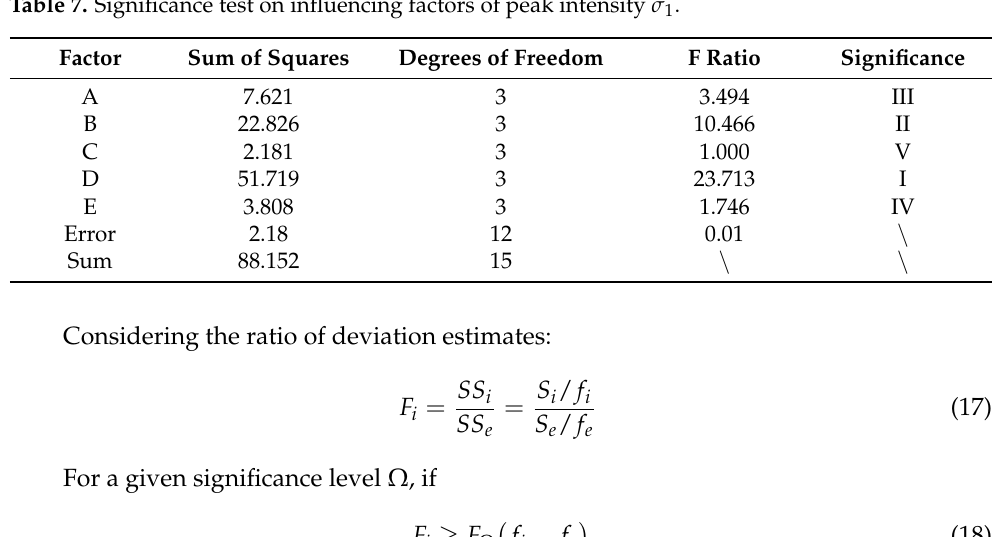
Table 7. Significance test on influencing factors of peak intensity σ 1